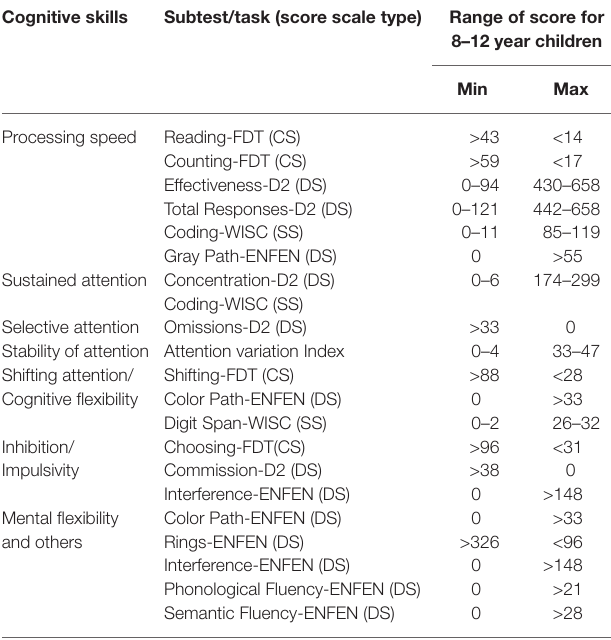
TABLE 2 | Summary of labeling of the subtests, cognitive skills measured, type and range of score. Cognitive